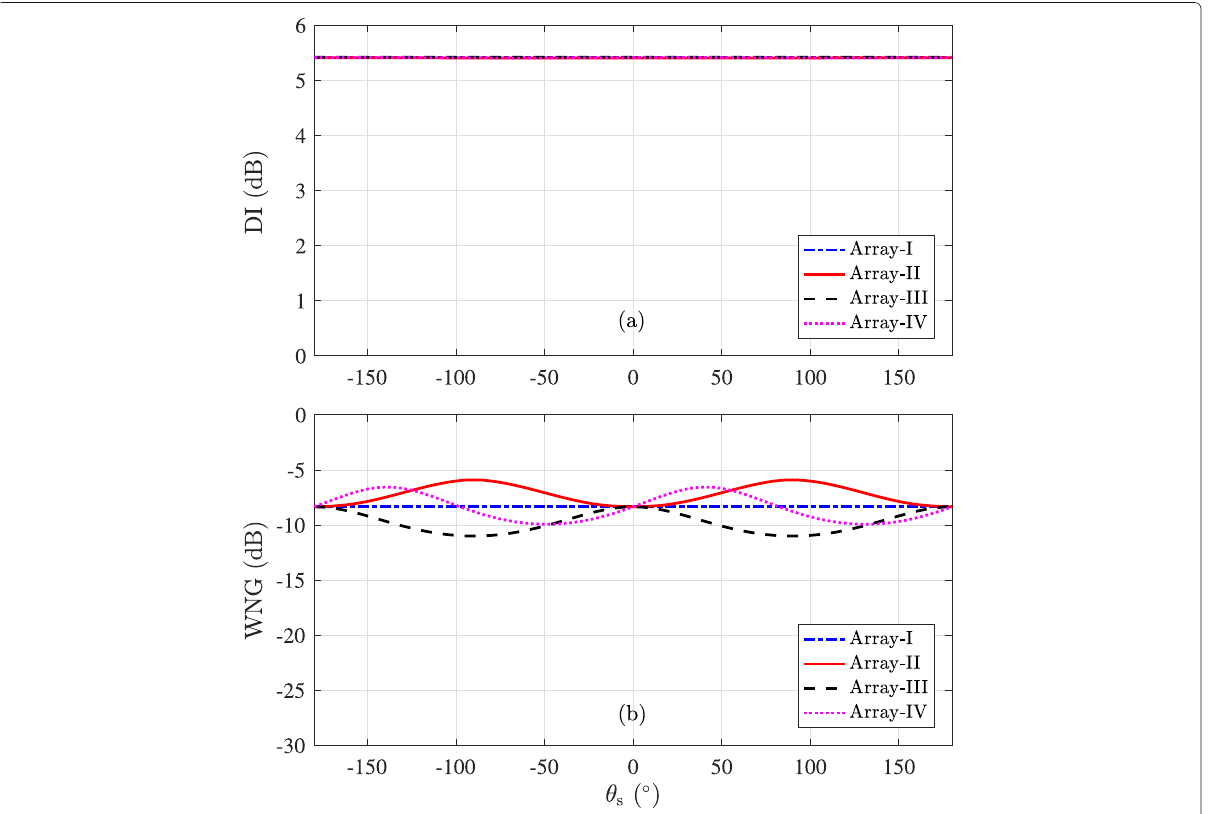
Fig. 4 DI and WNG of the first-order differential beamformer with four different array geometries for different look directions. a DI and b WNG